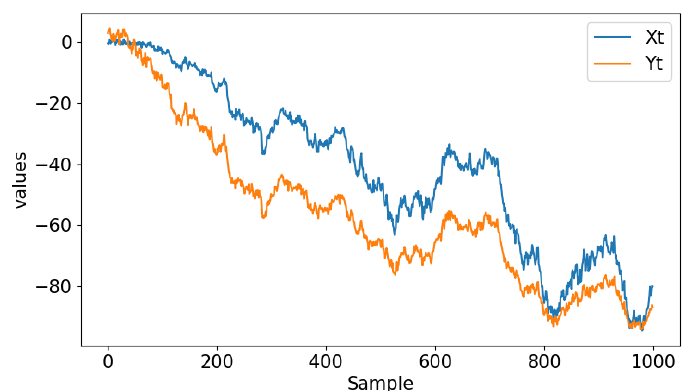
Figure 2. Two-dimensional simulation data.